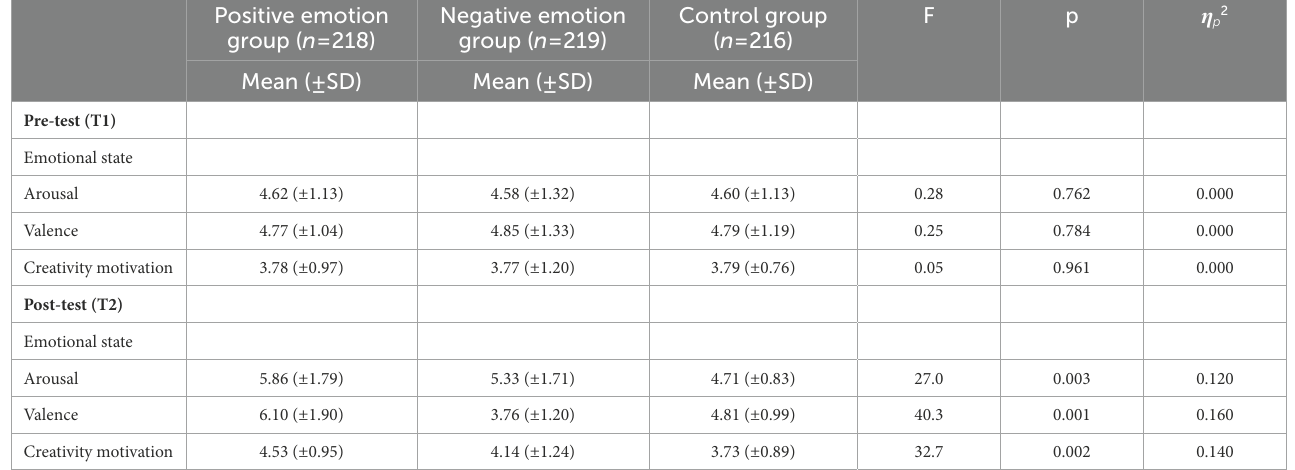
TABLE 4 Pre-and post-test measures of emotional state and creativity motivation in Study 2 ( n =